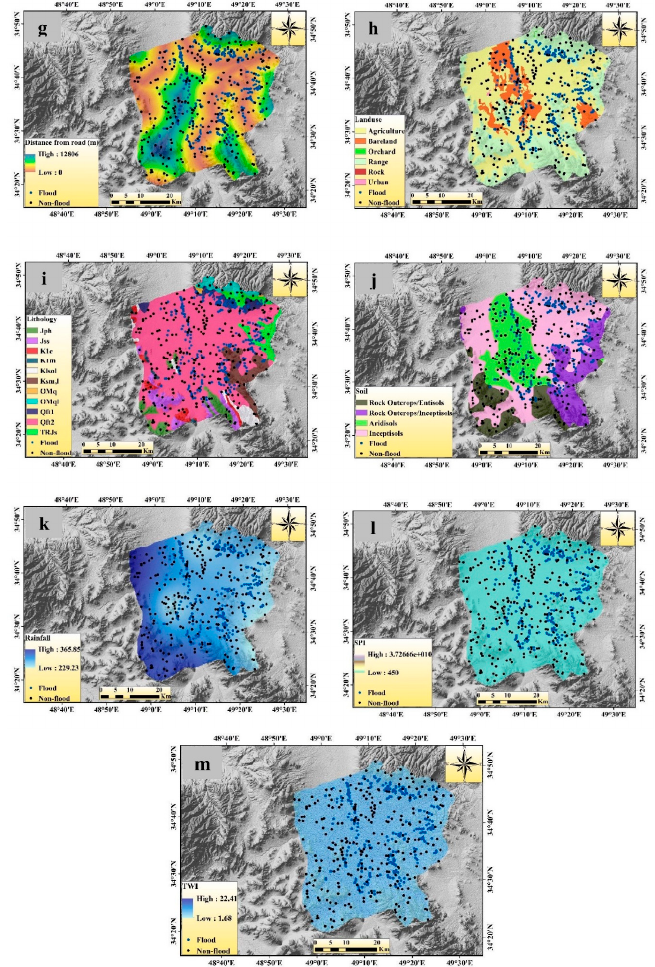
Figure 3. Flash flood susceptibility conditioning factors: ( a ) Altitude, ( b ) slope, ( c ) aspect, ( d ) plan curvature, ( e ) profile curvature, ( f ) distance from river, ( g ) distance from road, ( h ) land use, ( i ) lithology, ( j ) soil depth, ( k ) rainfall, ( l ) stream power index (SPI), ( m ) topographic wetness index (TWI).